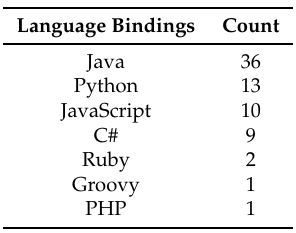
Table A2. 1.b. Which primary binding language do you use with Selenium?